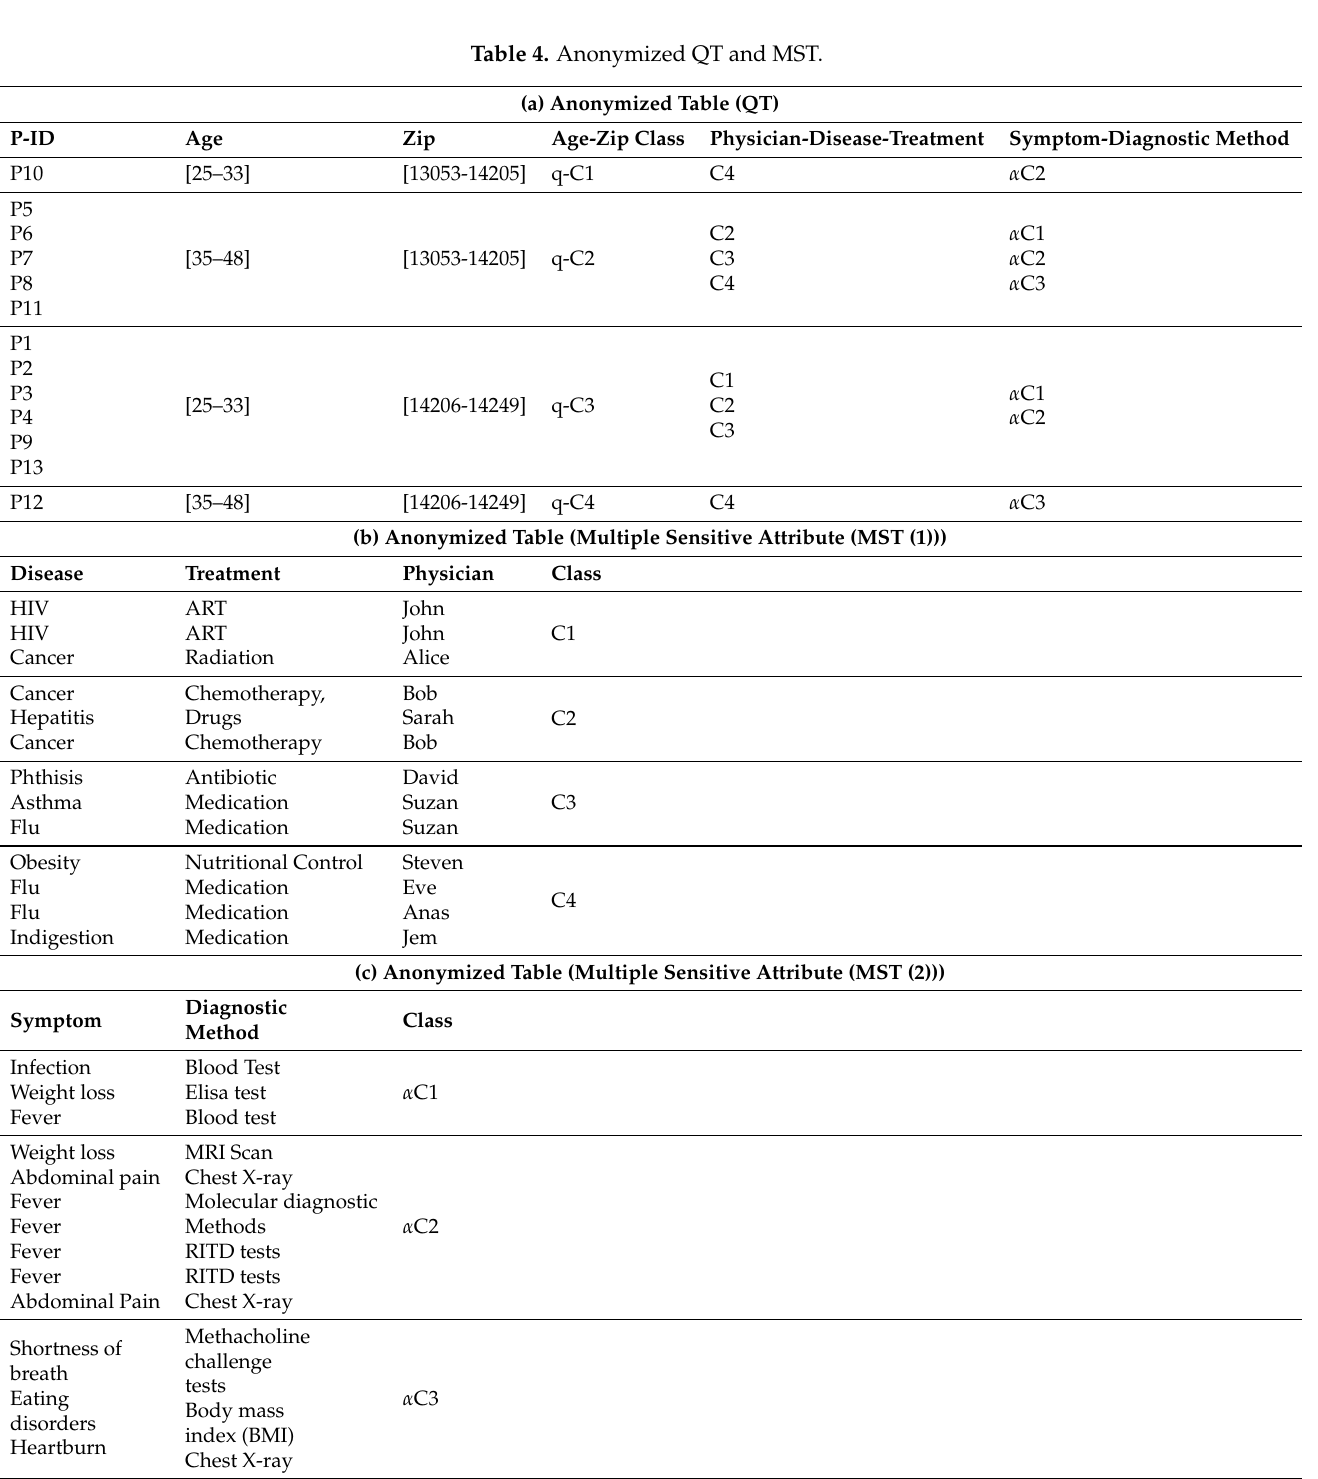
Table 4. Anonymized QT and MST. (a) Anonymized Table